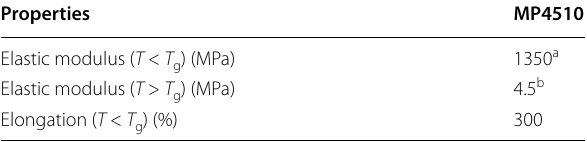
Table 1 Characteristics of SMP MP4510